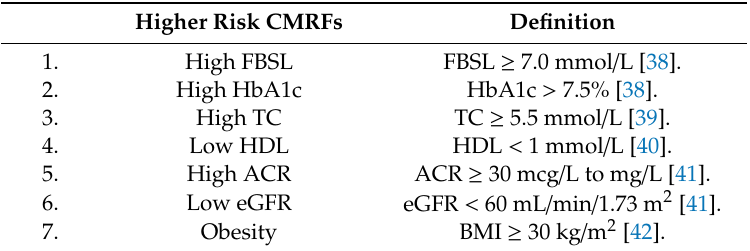
Table 1. Definitions of CMRF (cardiometabolic risk factor) test